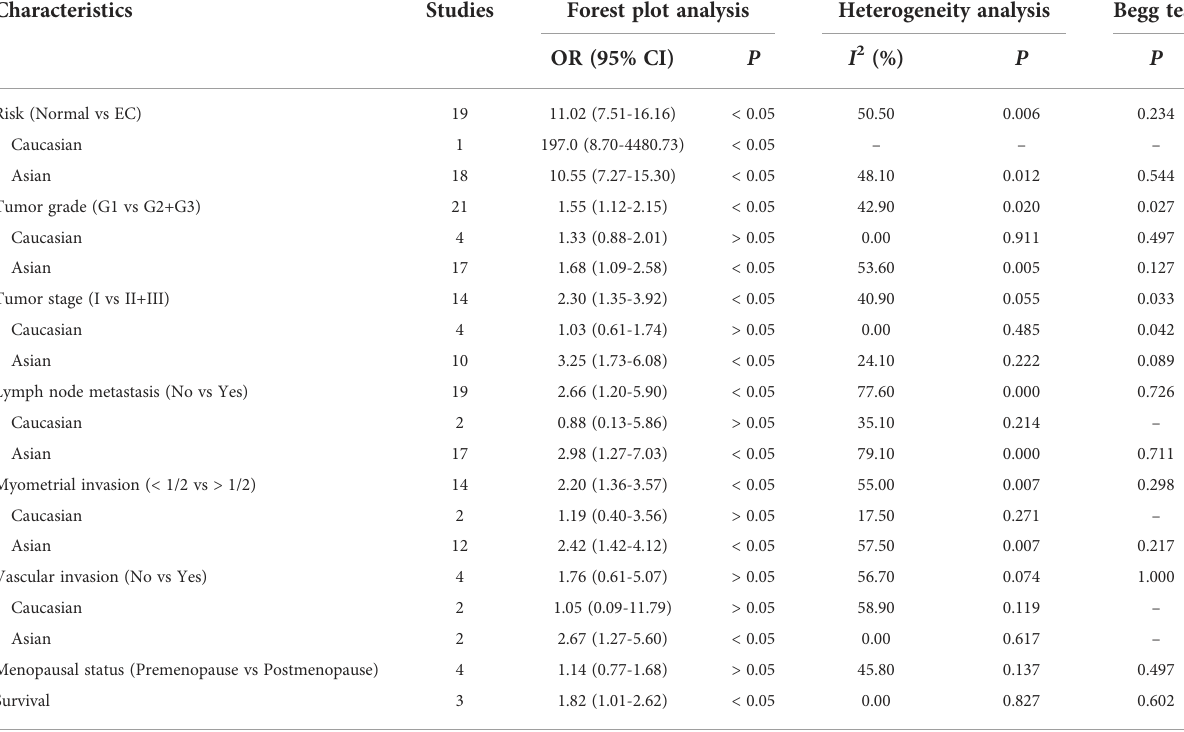
TABLE 2 Meta-analysis of the correlations of MMP-9 expression with risk, clinical features and prognosis of EC.